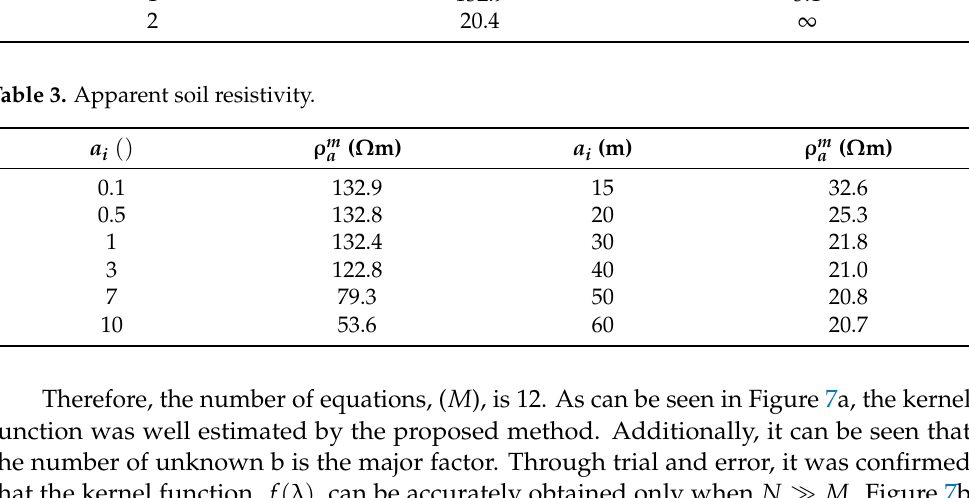
Table 4. Parameters of the four-layer soil structure.